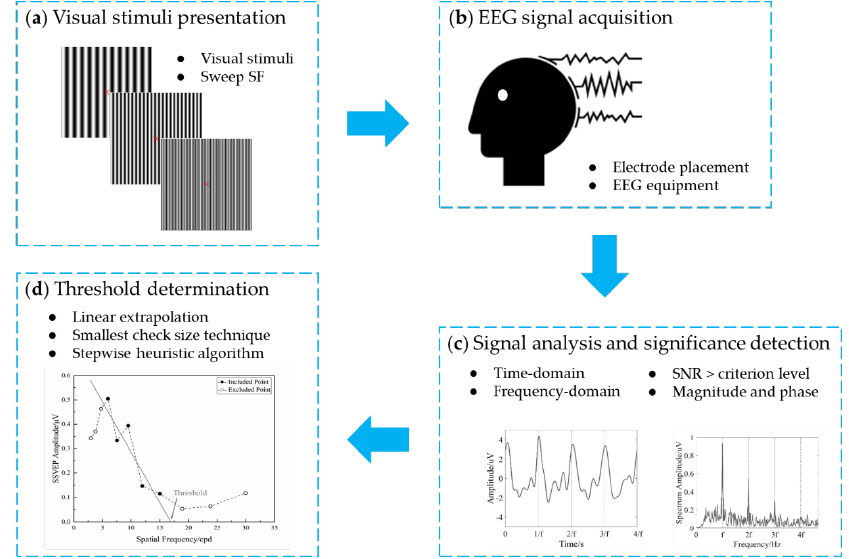
Figure 1. Broad overview of visual acuity assessment by visual evoked potential (VEP). ( a ) Visual stimuli presentation; ( b ) EEG signal acquisition; ( c ) signal analysis and significance detection; and ( d ) threshold determination. SF, spatial frequency.